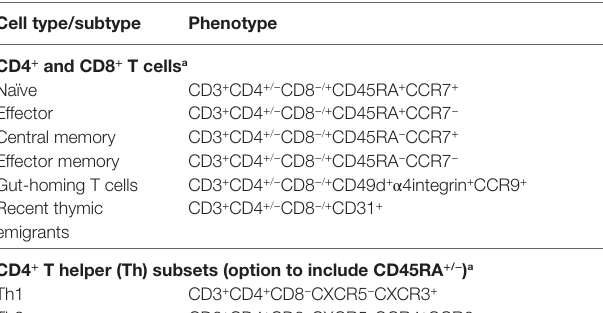
TABLe 1 | Flow cytometry antibody panels for immune cell reconstitution in